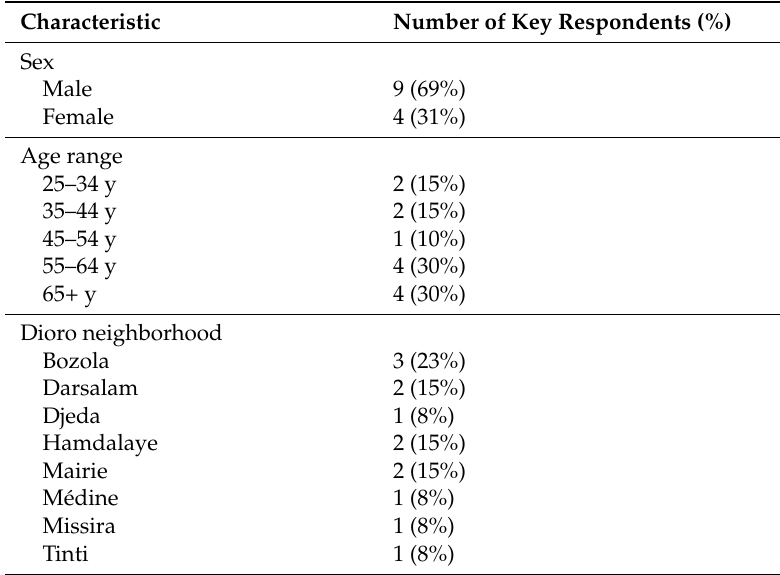
Table 1. Key respondent characteristics ( n =